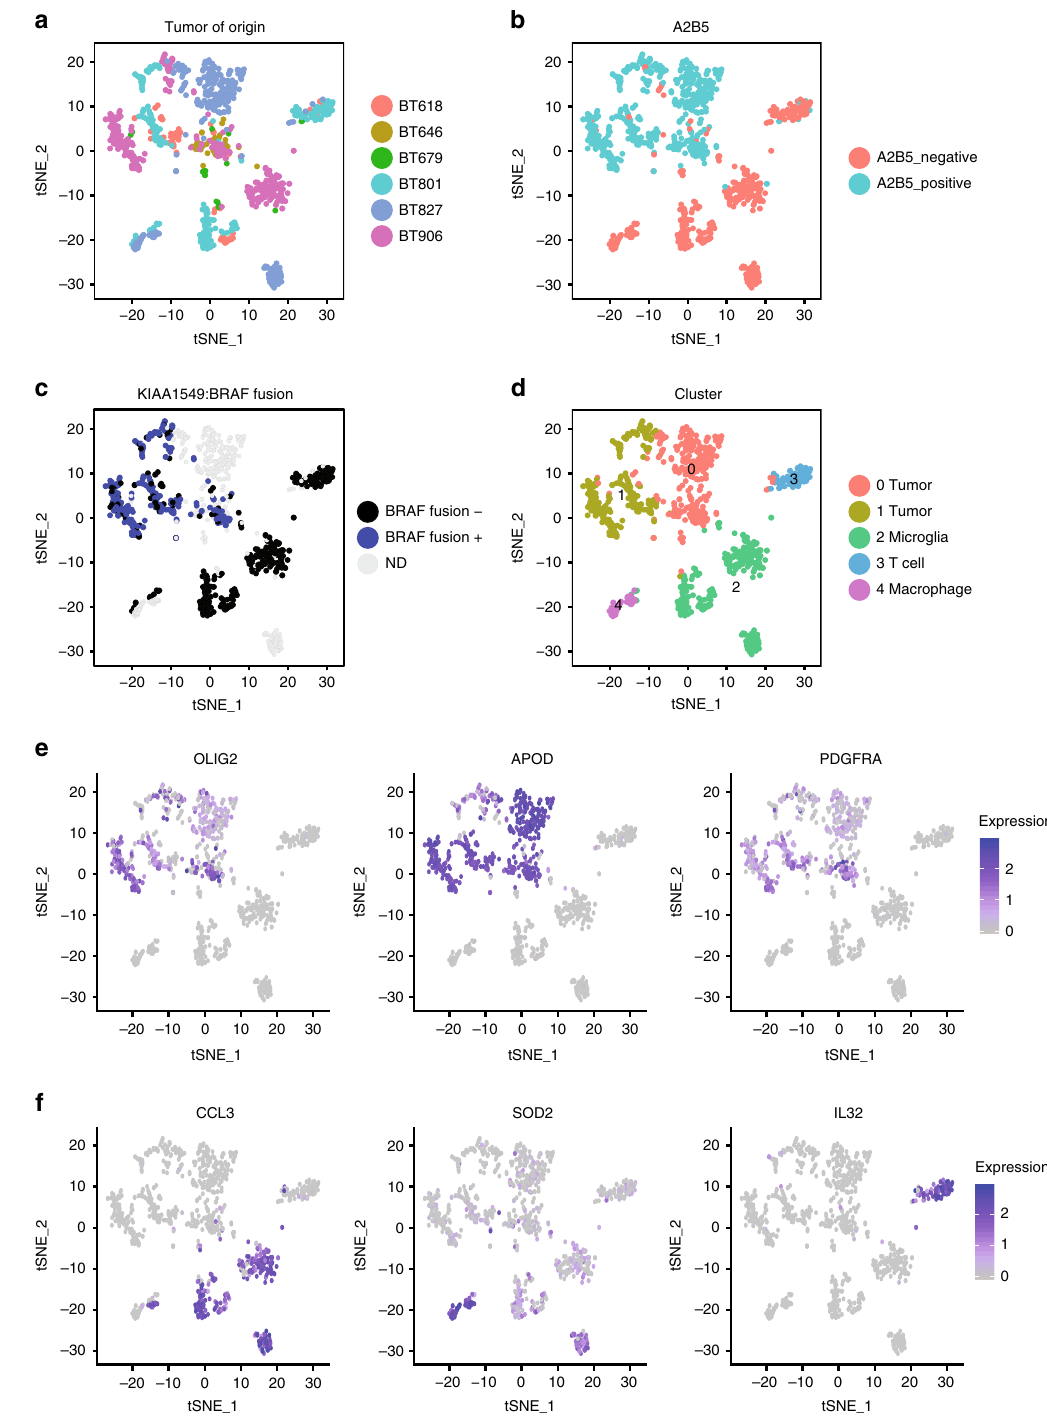
Fig. 2 Clustering of transcriptomic pro fi les corresponds to A2B5 and KIAA1549:BRAF status of PA cells. a t-SNE plot showing PA single cells colored by six tumors of origin. b t-SNE plot showing PA single cells colored by A2B5 glial progenitor marker status as determined by immunolabeling. c t-SNE plot showing PA single cells colored by KIAA1549:BRAF status as determined by BRAF Spike-in-Seq for cells undergoing quantitative PCR directed at the KIAA1549:BRAF fusion junction. d t-SNE plot showing PA single cells colored by shared nearest neighbors clustering of transcriptomic pro fi les revealing tumor clusters (0 and 1), a microglia cluster (2), a T cell cluster (3), and a macrophage cluster (4). e Relative expression of glial markers associated with PA OLIG2 , APOD , and PDGFRA . Scale shows log-normalized read counts. f Relative expression of markers of immune cells including CCL3 for microglia, SOD2 for macrophages, and IL32 for T cells. Scale shows log-normalized read